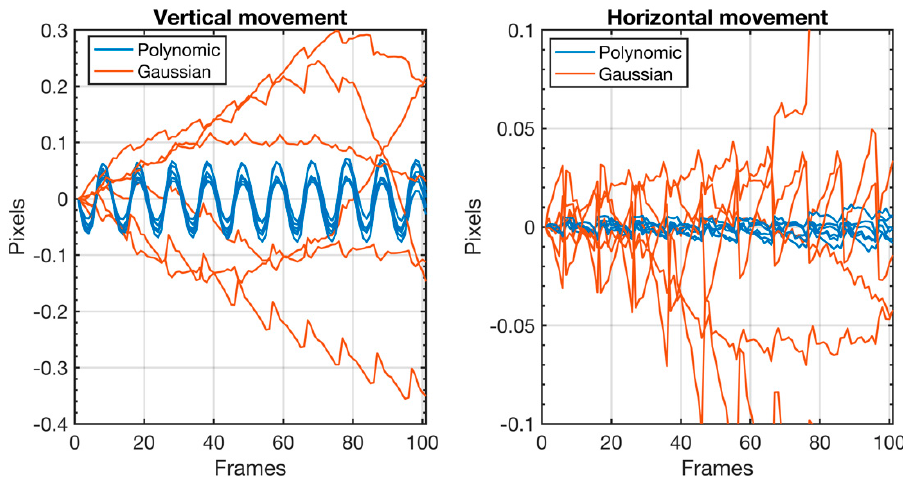
Figure 6. Location errors obtained for all the ROIs using polynomic and Gaussian fits in vertical ( left ) and horizontal ( right ) directions.